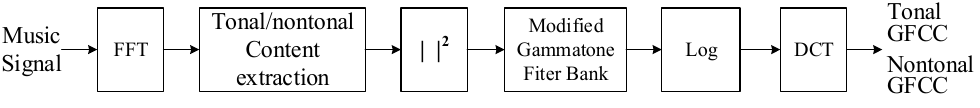
Figure 6. GMM–UBM based recognition system.